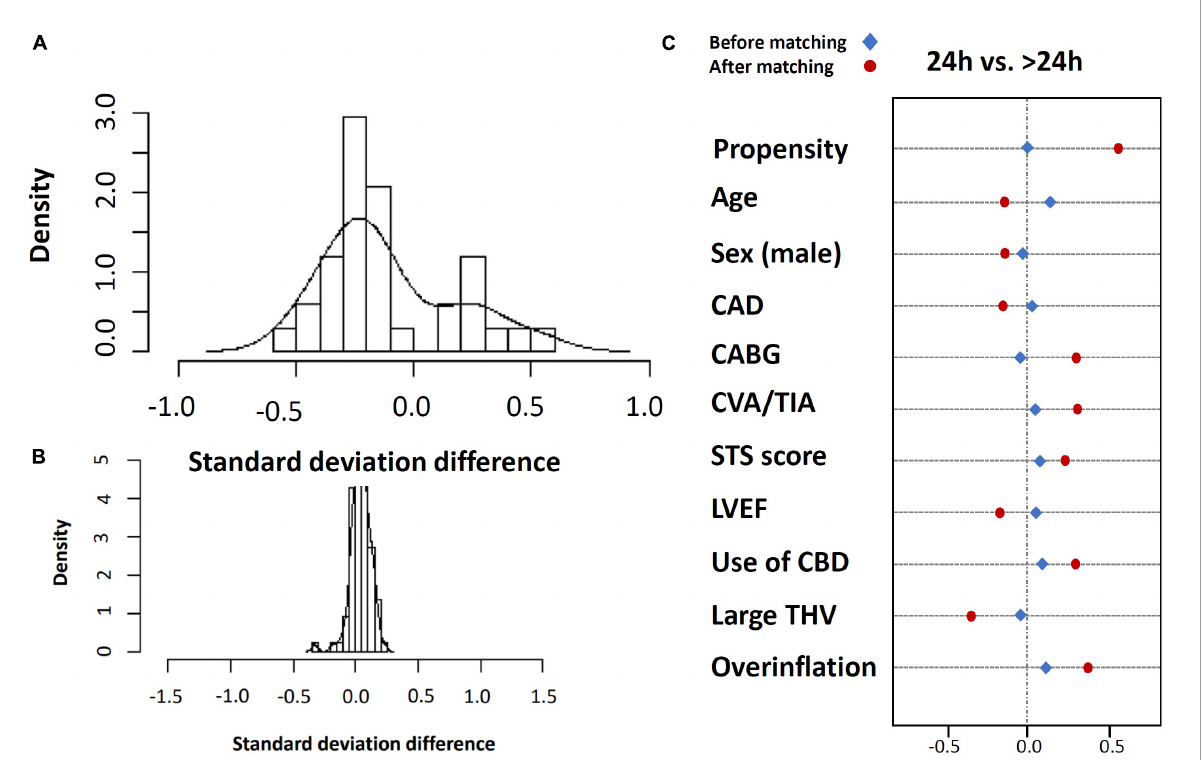
FIGURE5 Standard deviation before (A) and after (B) inverse propensity treatment weighting (IPTW) using propensity matching and covariate balance for entire matched population (C) .